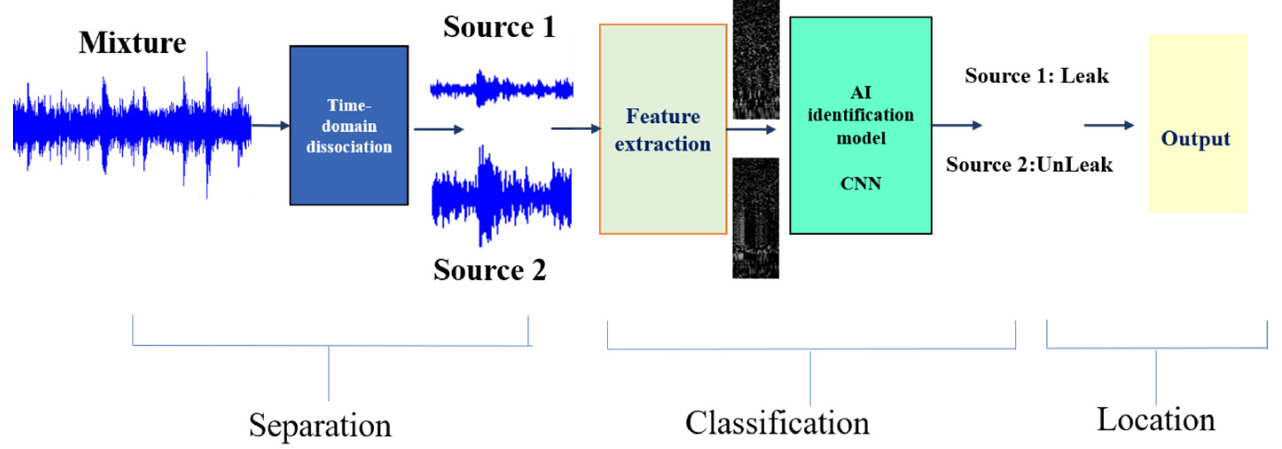
Figure 12. Flow chart of the whole system of intelligent sound-aided water leakage identification model.